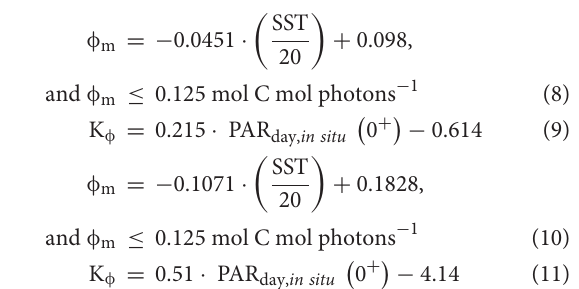
Frontiers in Marine Science |